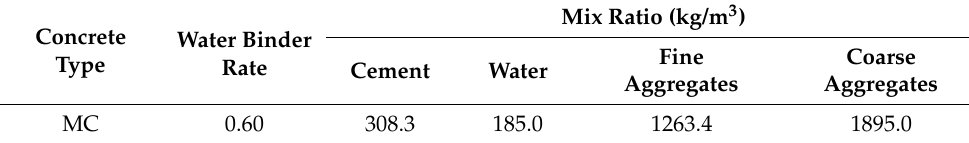
Table 3. Mix ratio of magnetite concrete.